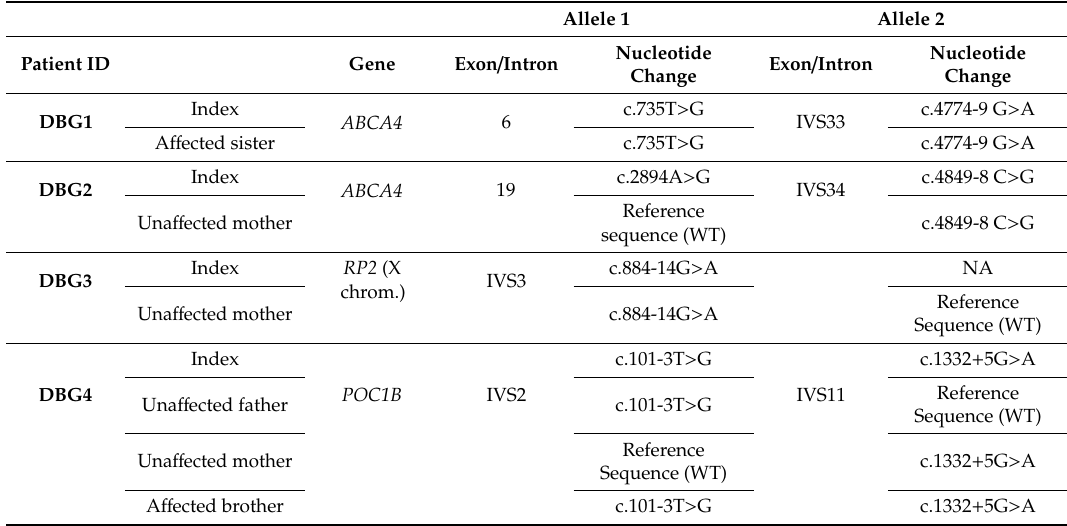
Table 2. Genotype of IRD patients and siblings. Gene, nucleotide and exon / intron position are indicated.